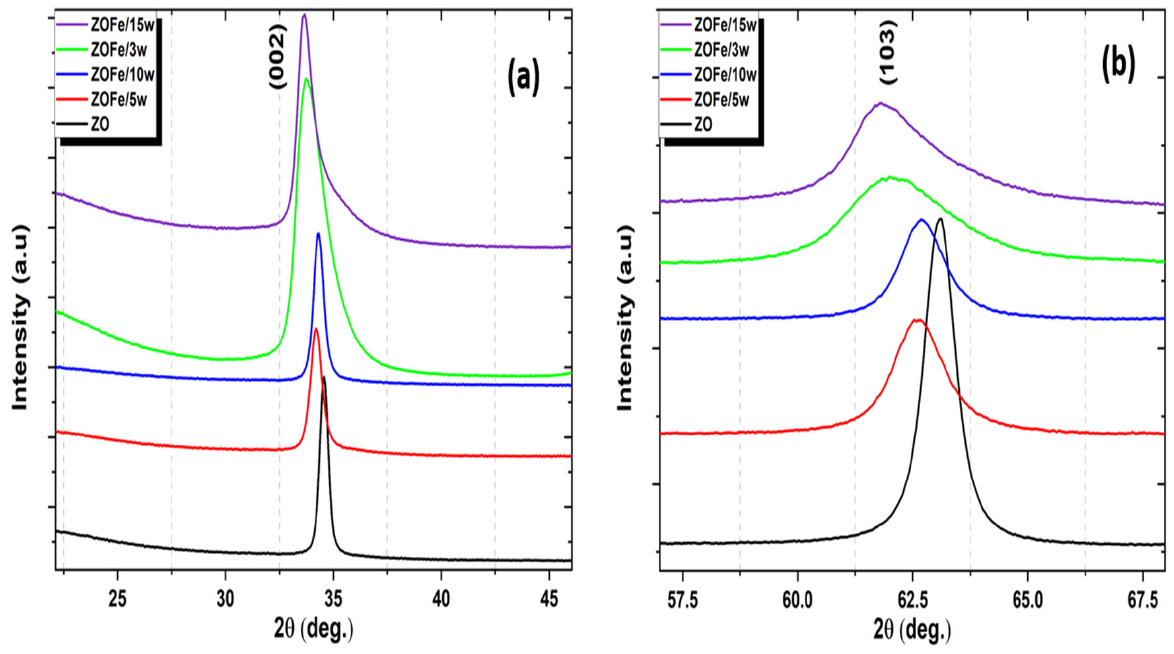
Figure 4. The peak shifts towards lower angle for all deposited films in planes ( a ) (002) ( b ) (103).